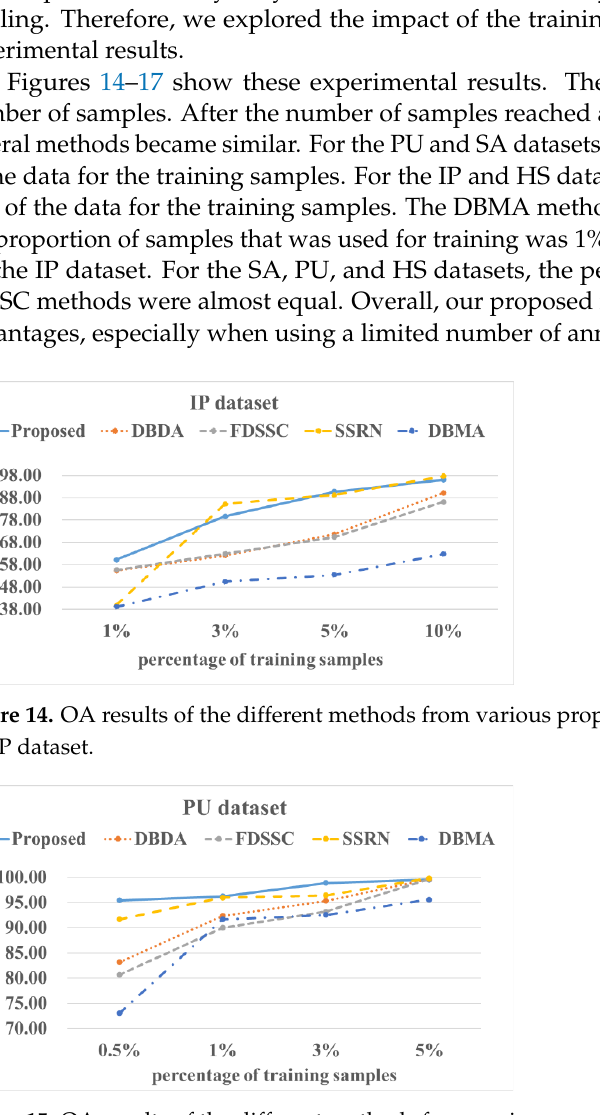
Figure 15. OA results of the different methods from various proportions of training samples using the PU dataset.